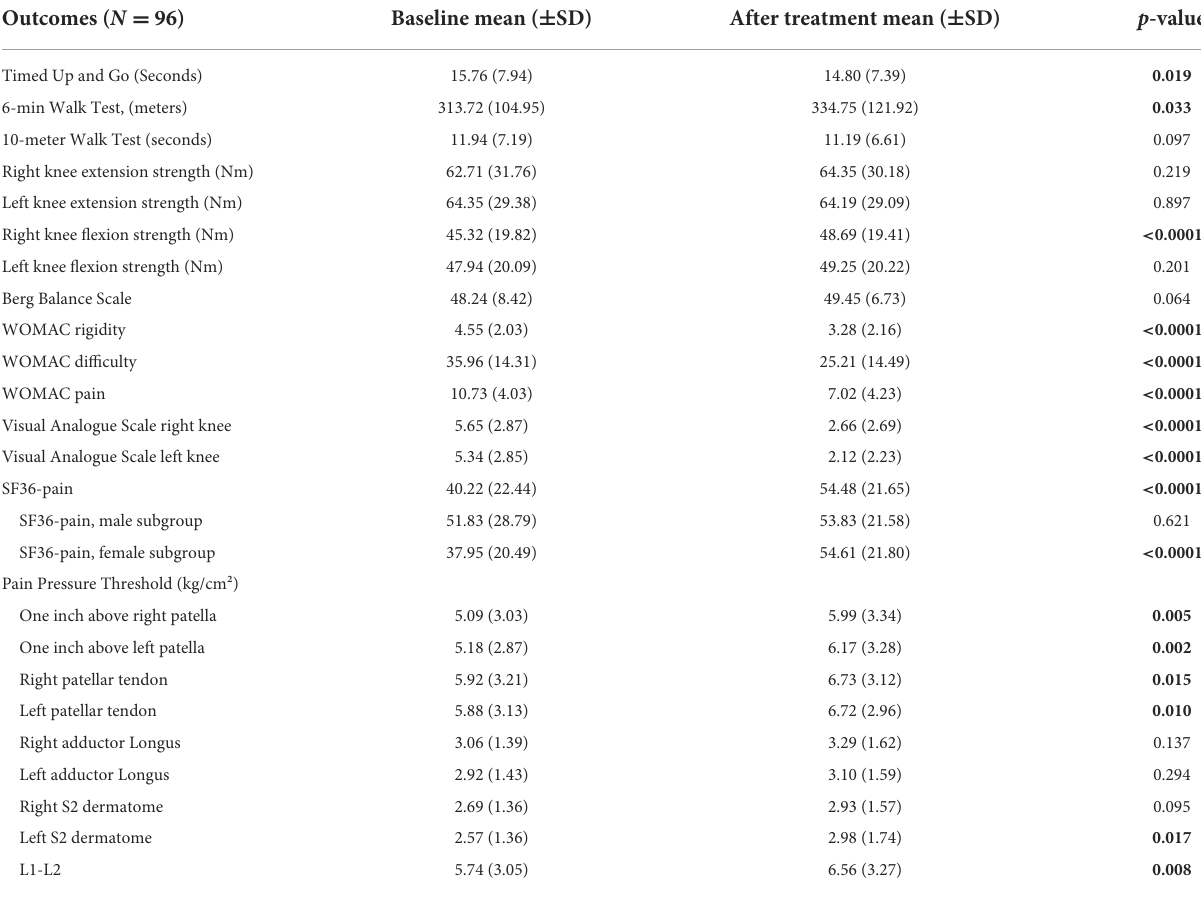
TABLE 4 Treatment